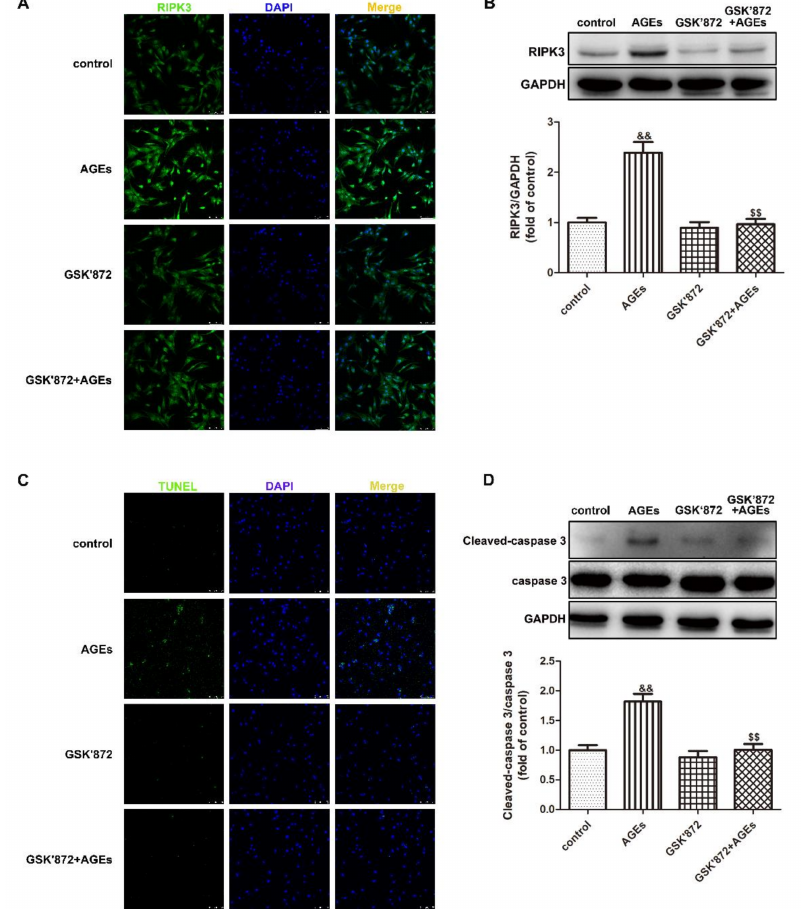
Figure 11. GSK (cid:48) 872 pretreatment inhibited necroptosis in cardiomyocytes. Cardiomyocytes were pretreated with 10 µ M GSK (cid:48) 872 for 4 h followed by 200 µ g/mL AGEs stimulation for 24 h. ( A ) RIPK3 was immunofluorescence stained by Alexa Fluor 488 (Green)-conjugated IgG. The nuclei were stained by DAPI (Blue). Bar = 75 µ m. ( B ) The expression of RIPK3was detected by Western blot in cardiomyocytes. GAPDH was used as a loading control. ( C ) The apoptosis of cardiomyocytes was detected by One Step TUNEL Apoptosis Assay Kit. Bar = 75 µ m. ( D ) The expression of caspase 3 and Cleaved-caspase 3 was detected by Western blot in cardiomyocytes. GAPDH was used as a loading control. Plots represent the mean ± SEM; n = 6. Statistical significance: && p < 0.01 compared with control; $$ p < 0.01 compared with